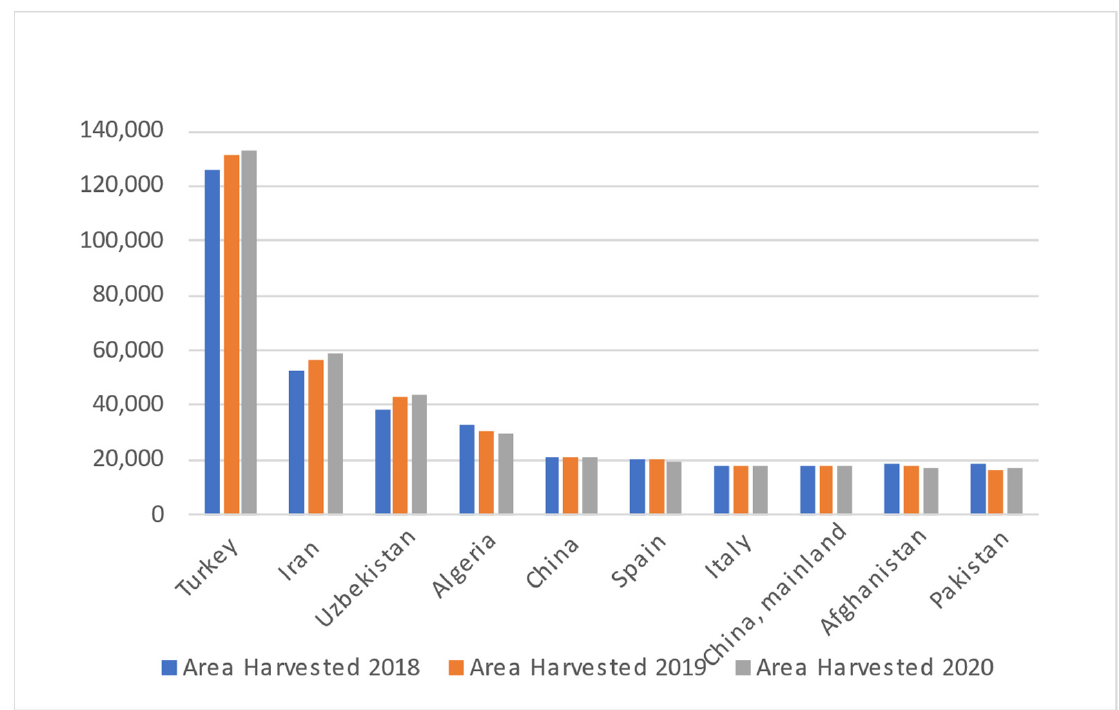
Figure 3. Area harvested of apricot for the top 10 Countries in the years 2018, 2019 and 2020.